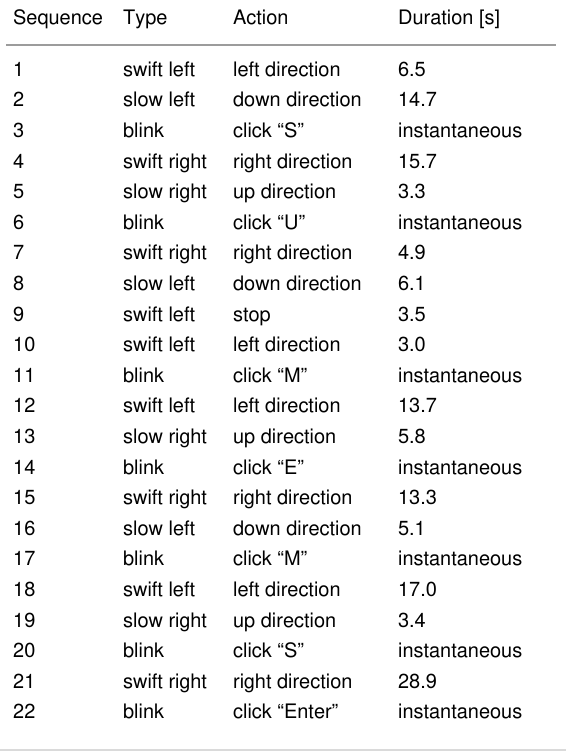
Table 1: Summary of eye movement types with corresponding cursor actions and a representative typing sequence. Sequence